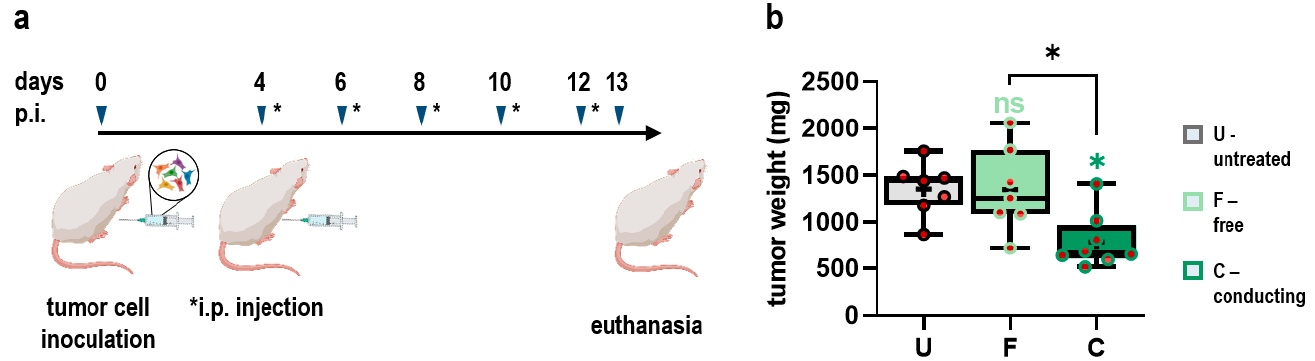
Figure 2. Conducting gas plasma treatment augments tumor toxicity of Ringer’s lactate solutions in a syngeneic mouse model of peritoneal carcinomatosis in vivo. ( a ) Experimental procedure; ( b ) 5–95% boxplots showing tumor weight of excised peritoneal tumor nodules. The mean is indicated as +. Statistical analysis was conducted using one-way analysis of variance (ANOVA) and Tukey’s post hoc testing (* p < 0.05). ns = nonsignificant; p.i. = post injection; i.p. = intraperitoneal; U = untreated; F = free mode; C = conducting mode.